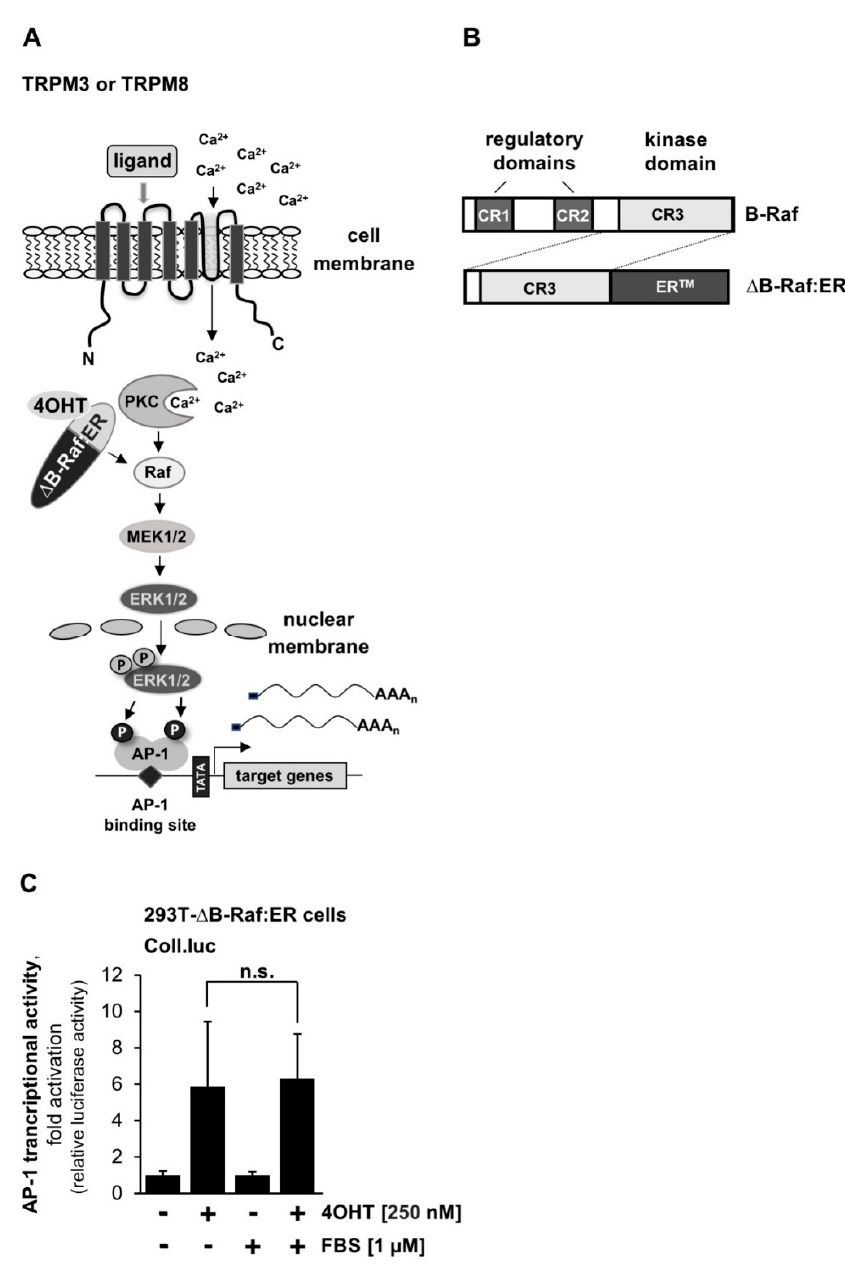
Figure 8. The compound m -3M3FBS fails to block B-Raf signaling. ( A ) Signaling pathway connecting TRPM8 and TRPM3 stimulation with AP-1-induced gene transcription. The activation point of the fusion protein ∆ B-Raf:ER is indicated. ( B ) Signaling pathway connecting TRPM8 and TRPM3 stimu- lation with AP-1-induced gene transcription. The activation point of the fusion protein ∆ B-Raf:ER is indicated. ( C ) HEK293- ∆ B-Raf:ER cells were infected with a recombinant lentivirus containing Coll.luc reporter gene. The cells were incubated in medium containing 0.05% serum for 24 h. Stimu- lation was performed with 4OHT (100 nM) for 24 h. Cells were harvested and analyzed as described in the legend to Figure 1 (n = 3; n.s., not